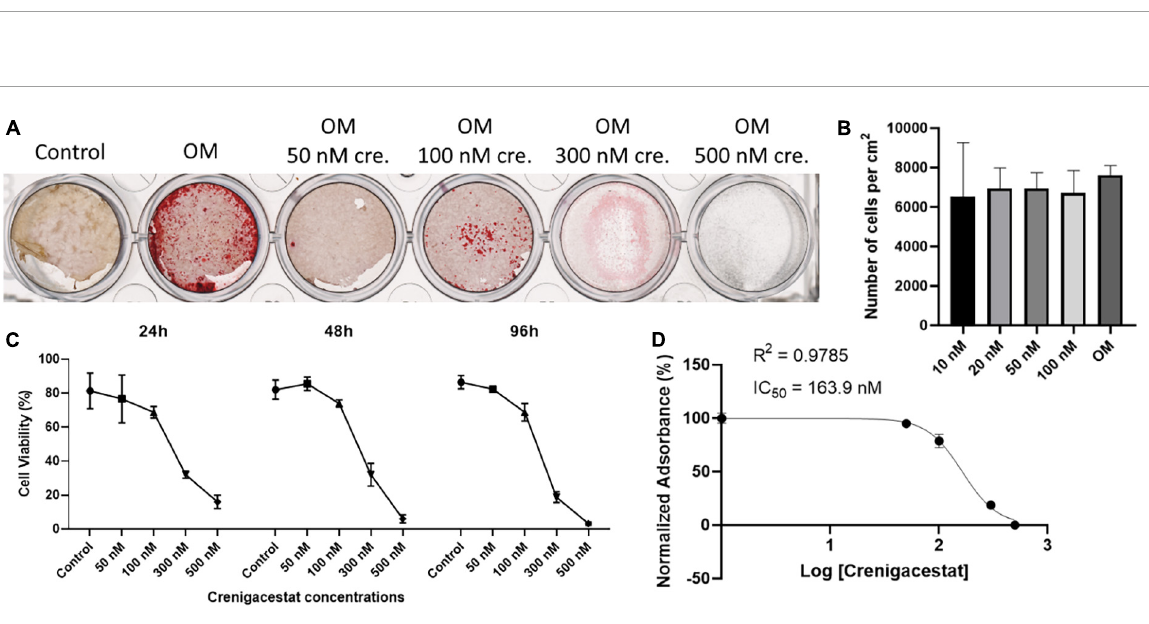
FIGURE2 Effect of different dosages of crenigacestat (LY3039478) on survival and osteogenic differentiation of human valve interstitial cells (VICs) in vitro . (A) Alizarin Red stain of VICs on the 21st day of cultivation in control, osteogenic medium (OM), and osteogenic medium supplemented with different dosages of crenigacestat (cre.) from 50 to 500 nM. (B) Boxplot demonstrated the number of VICs cultured in osteogenic media in control conditions or with treatment by different dosages of crenigacestat at 96 h after induction of differentiation and crenigacestat treatment. (C) Plot representing effect of different crenigacestat dosages on cell viability relatively to control group in different timepoints. Each point represents an average of three independent replicates with standard error of the mean. (D) Sigmoidal curve for MTT assay showing IC50 value of crenigacestat on VICs. Each point represents an average of three independent replicates with standard error of the